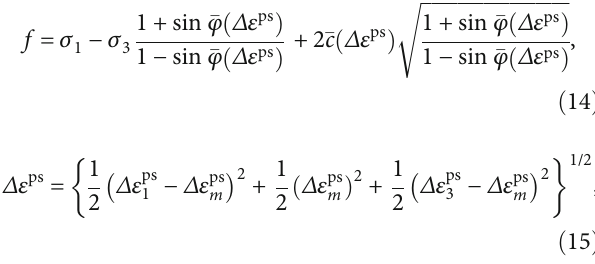
ffiffiffiffiffiffiffiffiffiffiffiffiffiffiffiffiffiffiffiffiffiffiffiffiffiffiffiffiffi